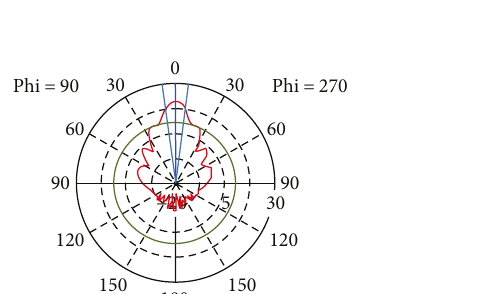
Figure 7: Microwave WPT system.